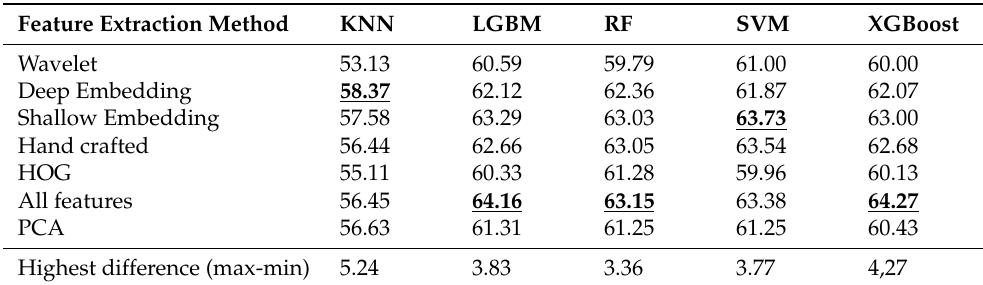
Table 3. Summary of the accuracy for 5 classifiers trained using extracted feature sets. The best result for each classifier is